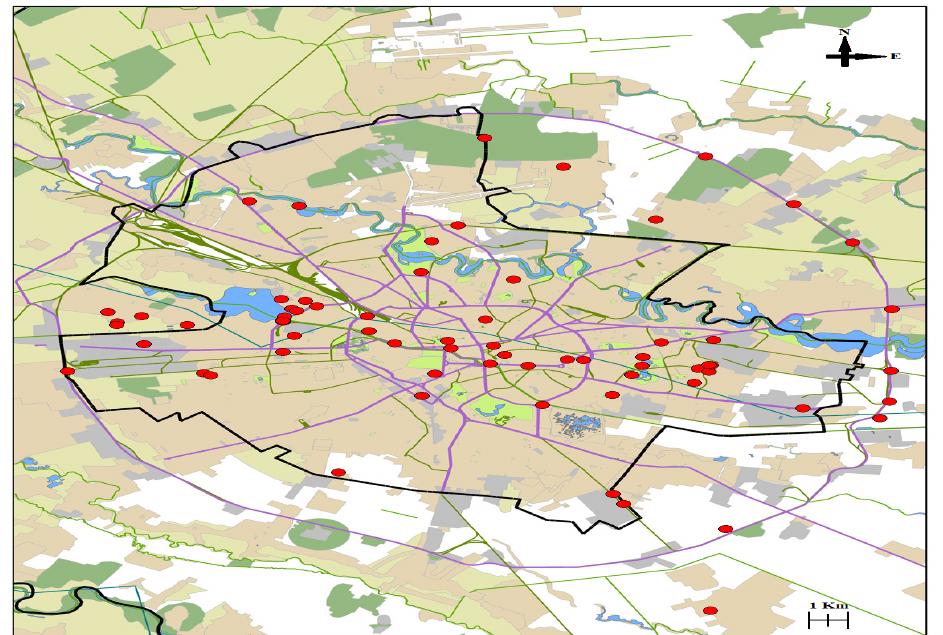
Figure 2. The spread of the weed Ambrosia artemisiifolia in Bucharest area (reported by Sorin Stefanut in 2018, original work, unpublished, reproduced with author’s permission), 44° latitude and 26° longitude. The red dots represent notably invaded sites in both public and private properties, the black line delimits the urban area, surrounded by suburban localities and the purple lines indicate the main traffic roads.